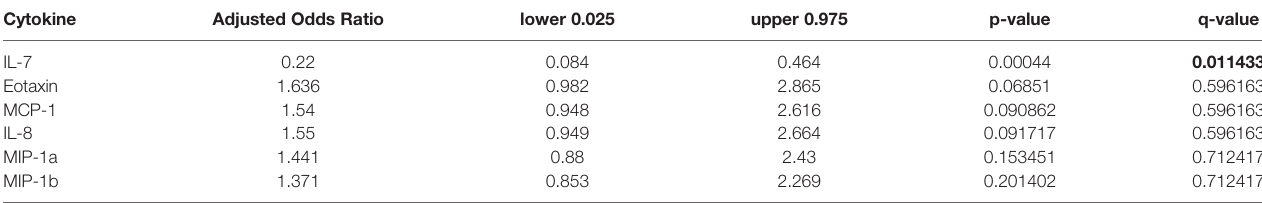
TABLE 2 | Cytokine Odds Ratio For Surgical vs. Non-surgical Management. Cytokine Adjusted Odds Ratio